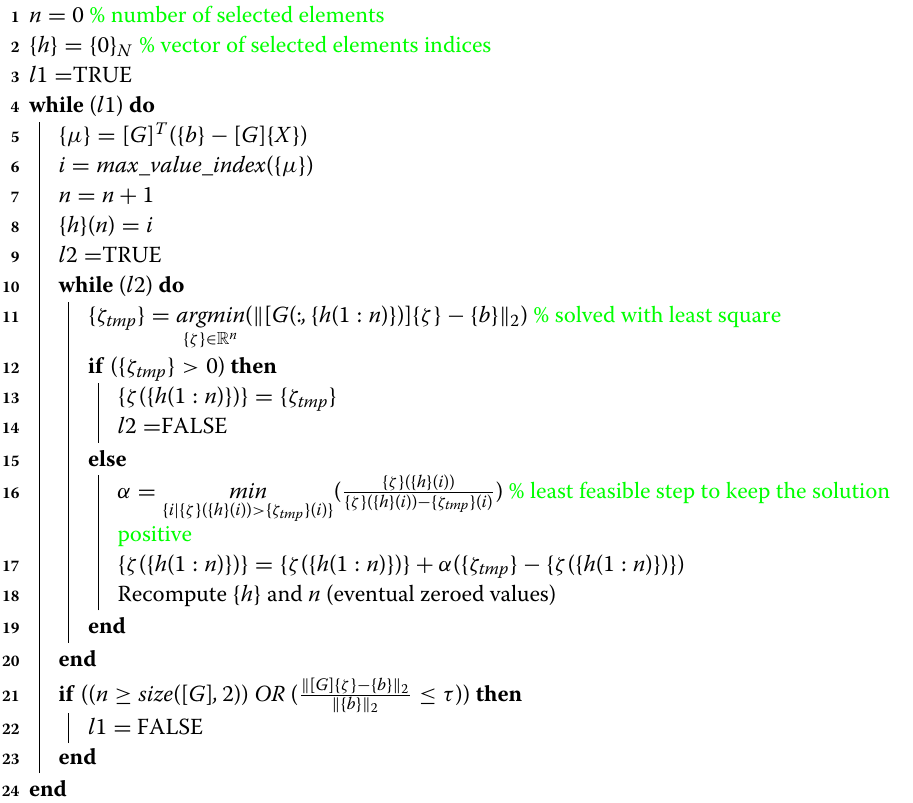
Algorithm 1: SNNLS( [ G ] , { b } , { ζ } , τ